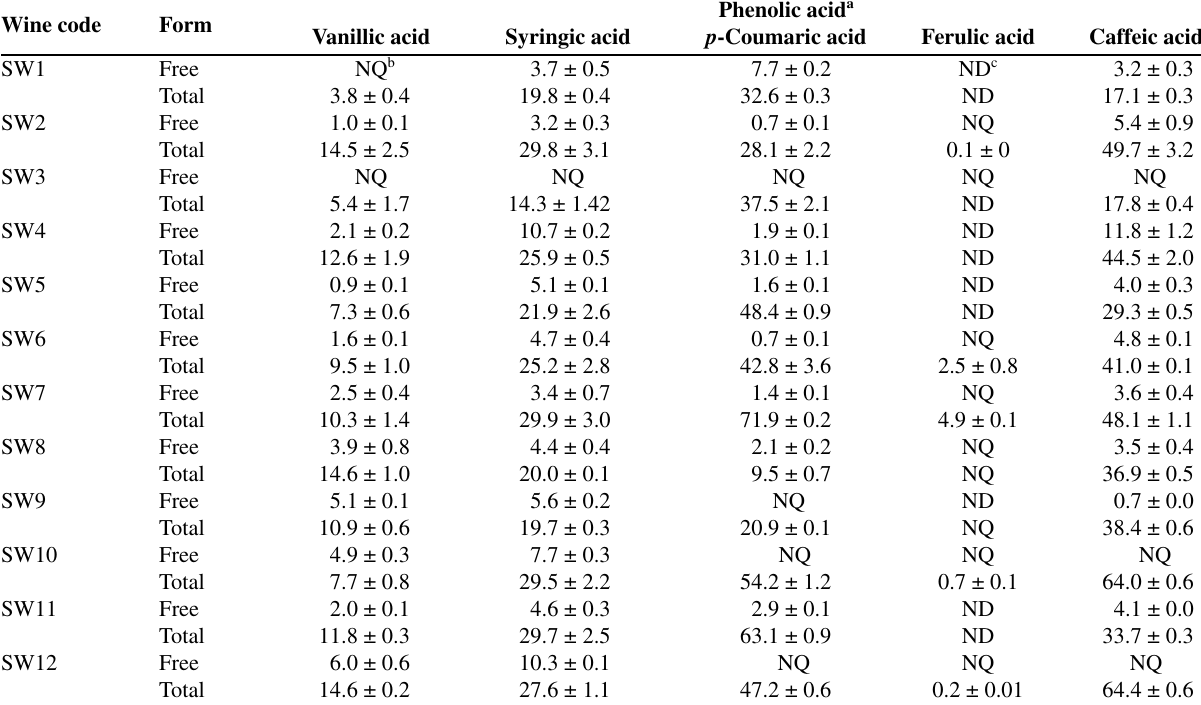
Table 6. Content (mg L –1 ) of free and total PAs in Slovenian red wines.